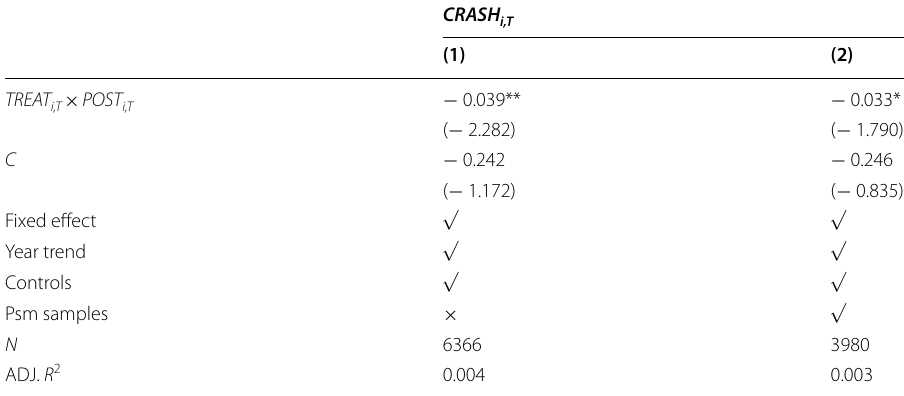
In this paper, ***, **, and * represent the significance levels of 1%, 5%, and 10%, respectively. The t-value is in parentheses